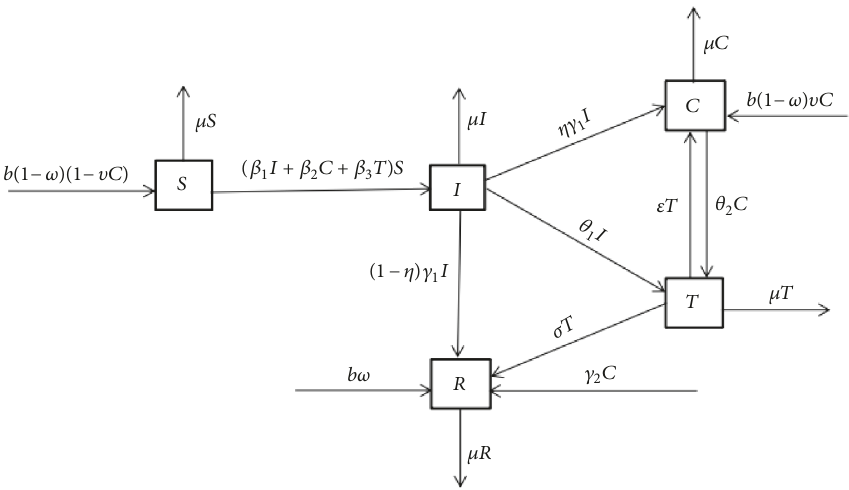
Figure 1: Flow chart of the epidemiological classes for the